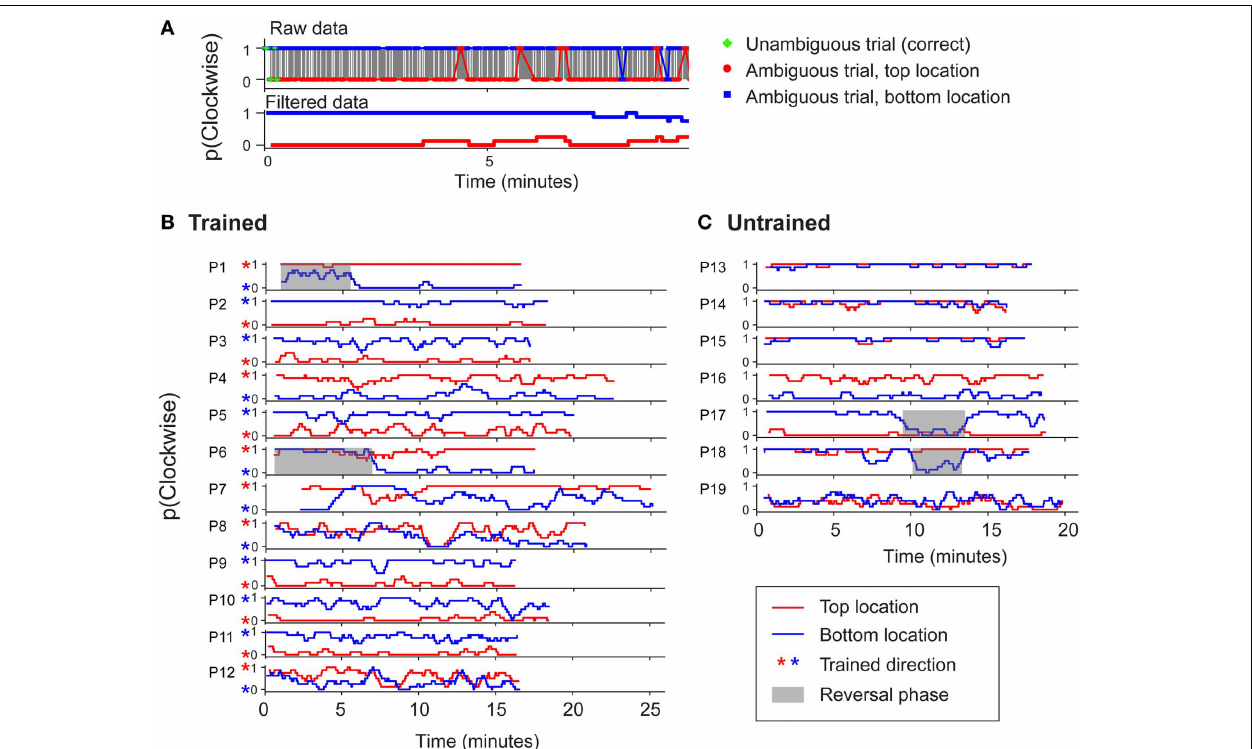
FIGURE 4 | (A) An example to illustrate how raw perceptual report data from individual observers was boxcar filtered (with a window size of 8 trials) to enhance clarity in (B) and (C) . (B) Perceptual report data from observers in the trained group in experiment 1 for two consecutive blocks of 400 trials each. Red asterisks indicate the